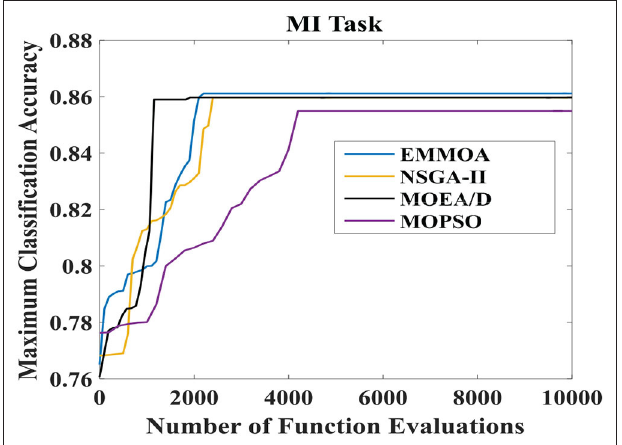
FIGURE 5 | Convergence of four algorithms for MI task.